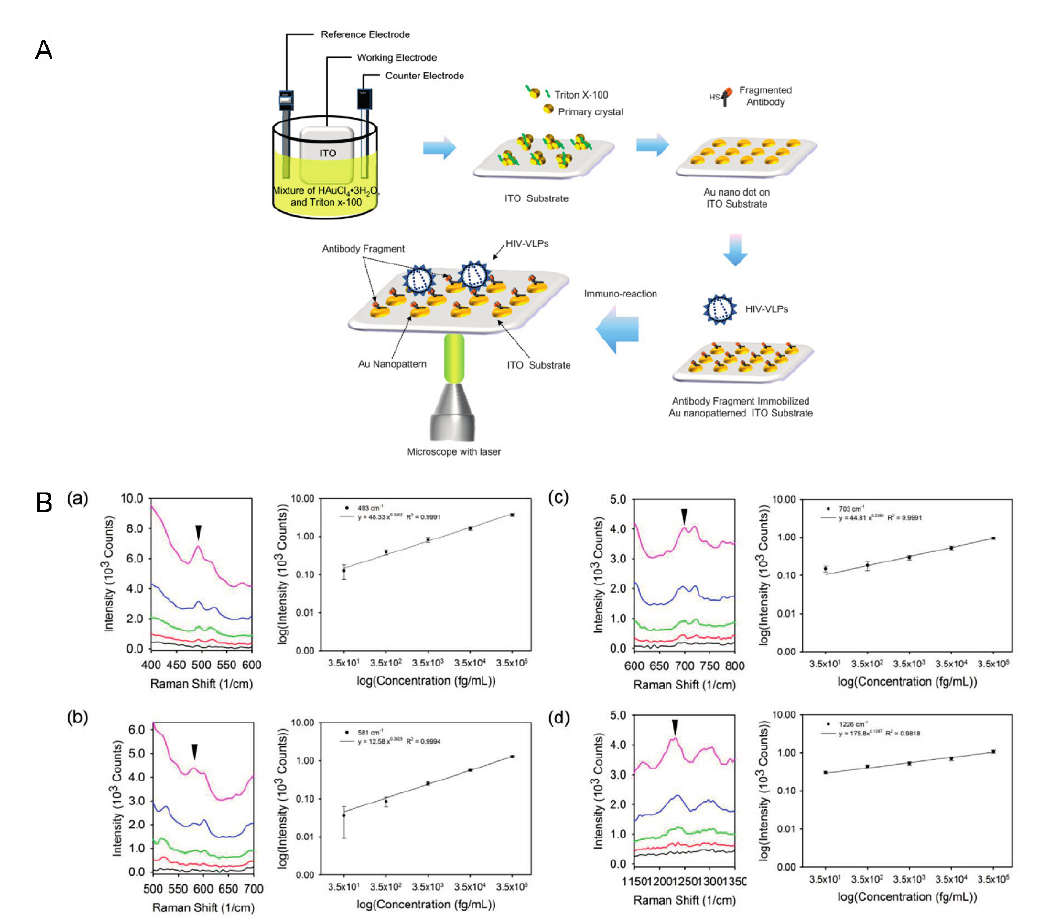
Figure 4. Optical detection of HIV-1 virus based on SERS. ( A ) Schematic representation of electrochemical deposition of uniformed Au nanodots and the immunoassay configuration using the SERS technique for the rapid and sensitive measurement of HIV-1; ( B ) The SERS spectra showed the changes in intensity of Raman peaks and linear plots related to different concentrations of HIV-1 VLPs. Figure reproduced with permission from